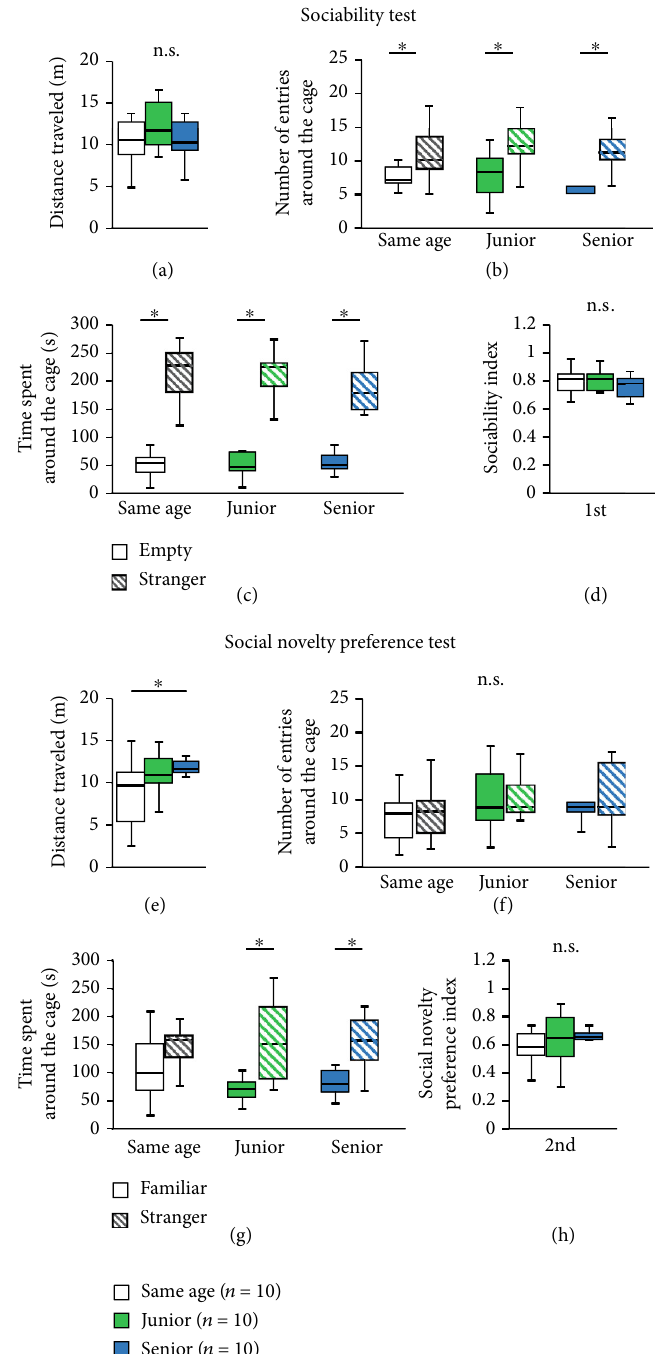
Figure 4: E ff ect of housing condition on performance in the social interaction test. The sociability test: graphs showing the total distance traveled ( a ), the number of entries around the cage ( b ), the time spent around the cage ( c ), and the sociability index de fi ned as the ð time spent around the stranger cage Þ / ð time spent around the strangercage + timespent around the empty cage Þ ( d ). The social novelty preference test: graphs showing the total distance traveled ( e ), the number of entries around the cage ( f ), the time spent around the cage ( g ), and the social novelty preference index de fi ned as the ð time spent around the strangercage Þ / ð time spent around thestranger cage + timespent around the familiarcage Þ ( h ). All data are presented as box plots. ∗ Signi fi cant di ff erence in comparisons between groups ( p < 0 : 05 ). The p values were calculated using two-way ANOVA in (a), (d), (e), and (h), and two-way repeated measures ANOVA in (b), (c), (f), and signi fi cant intergroup di ff erences in locomotor activity during Fisher ’ s LSD test: same age vs. junior, p = 1 : 0 ; junior vs. senior, p = 0 : 271 ; same age vs. senior, p = 0 : 166 ; fi rst light phase, two- the fi rst dark phase (Figure 5(a), fi rst dark phase: two-way repeated measures ANOVA: F way repeated measures ANOVA: F = 12 : 405 , p < 0 : 001 ; = 9 : 960 , p < 0 : 001 ; 23 , 644 23 , 644